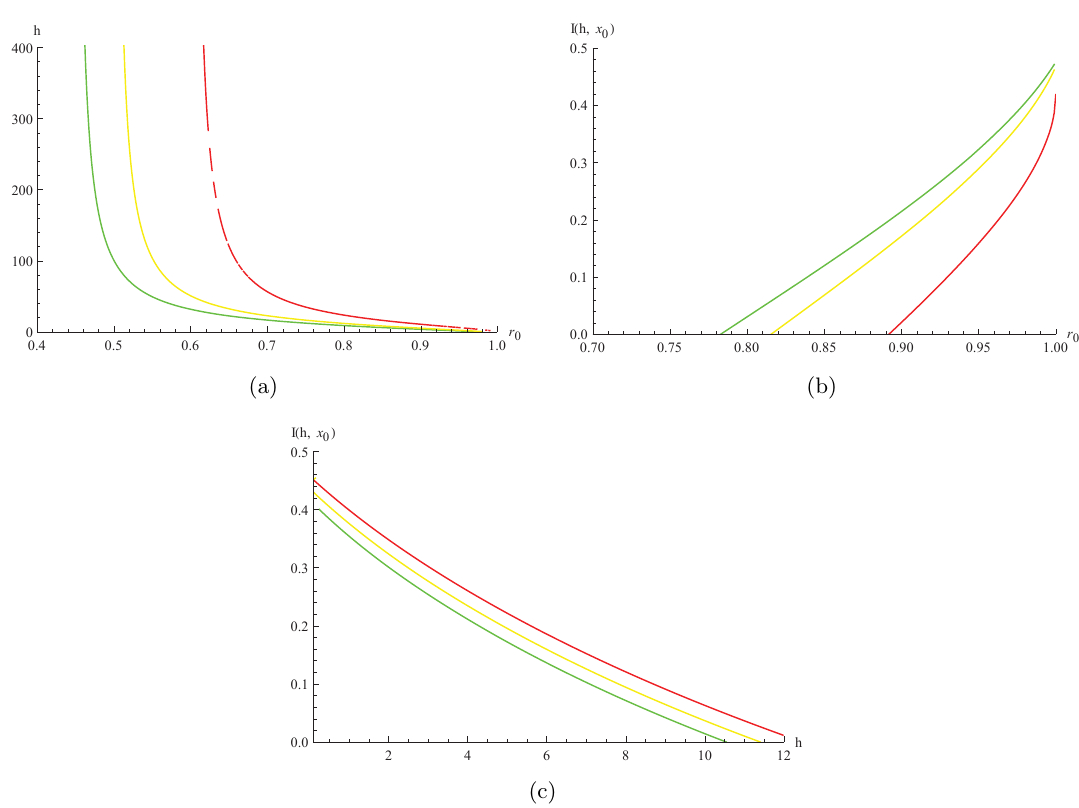
Figure 7 . Panel (a): the relation between the shift h and the minimal radius r 0 for various charges Q ; panel (b): the relation between the mutual information I ( h; x 0 ) and r 0 for di(cid:11)erent Q ; panel